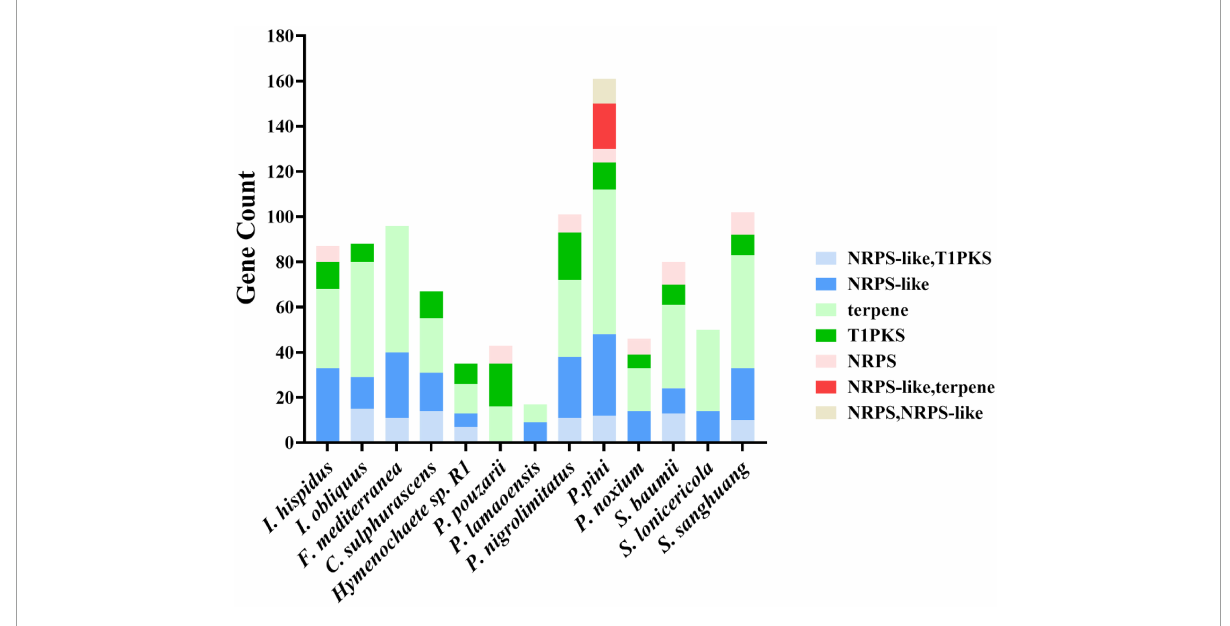
FIGURE8 Genome sequence comparison of the secondary metabolite biosynthetic gene